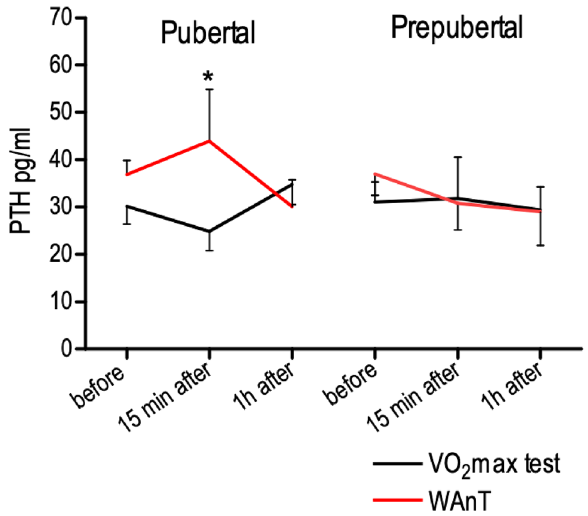
Figure 4. The PTH concentration before, 15 min after and 1 h after a single bout of exercise in pubertal (n = 7 for VO 2 max test, and n = 7 for WAnT test) and prepubertal (n = 5 for VO 2 max test, and n = 7 for WAnT test) boys according to two types of exercise (VO 2 max and WAnT tests). *p = 0.024—difference between indicated result/ mean and the results 1 h after in the same group and test, LSD post hoc test after repeated measures ANOVA.